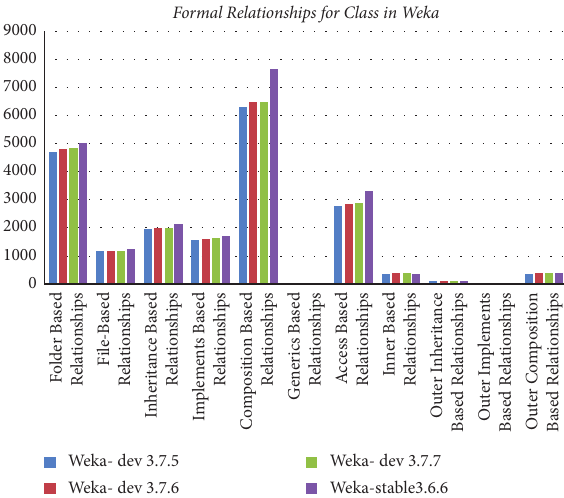
Figure 22: Count of formal relationships for class in weka.